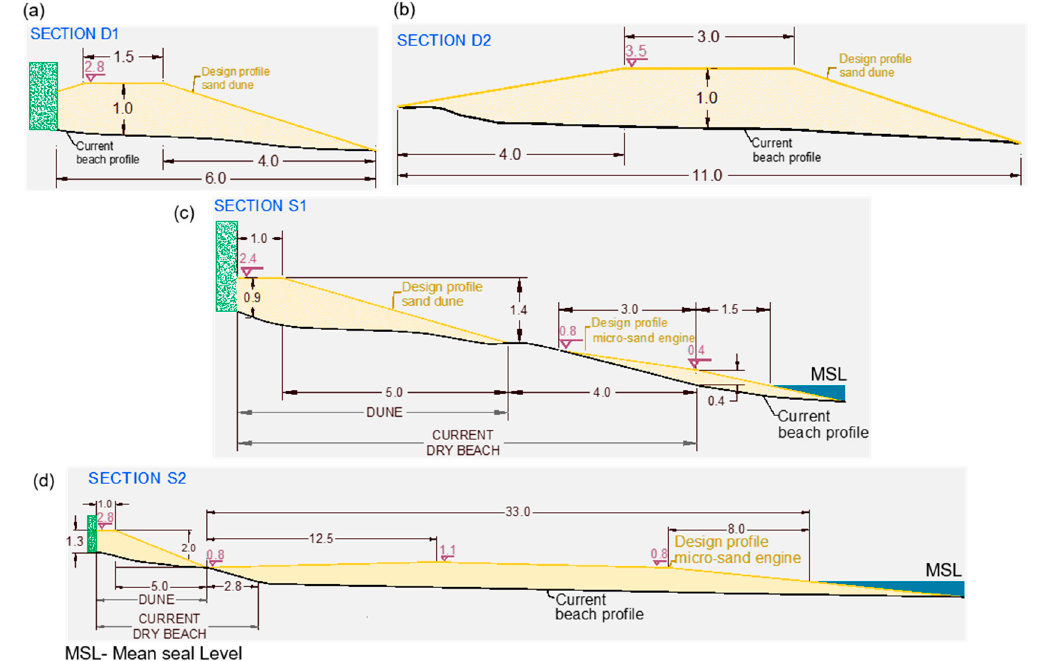
Figure 7. Beach profile designs: ( a ) ‐ ( b ) coastal dune; ( c ) ‐ ( d ) micro Sand Engine.